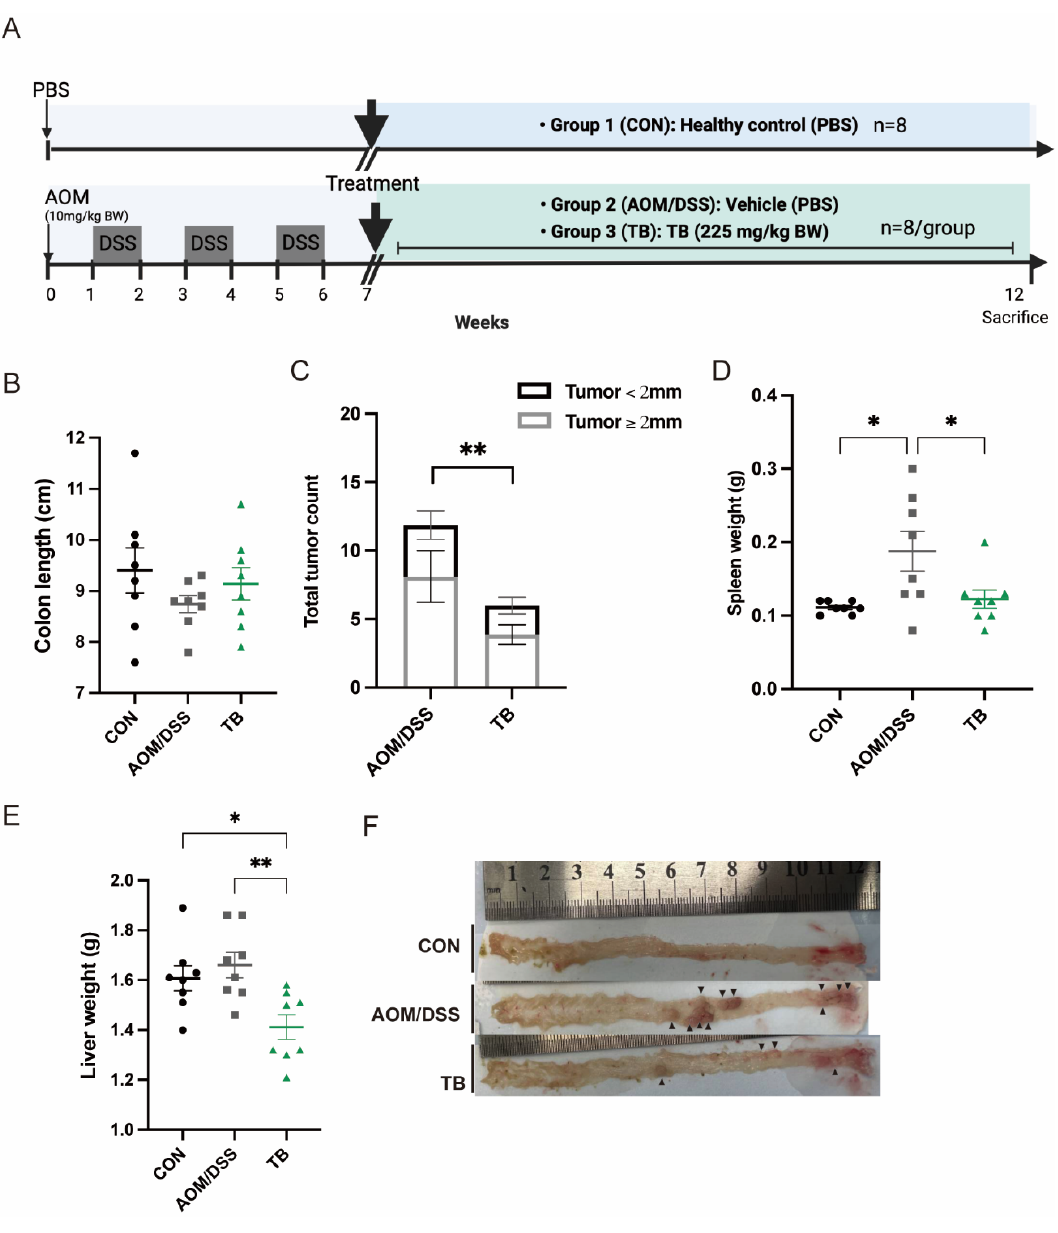
Figure 1. TB suppresses the development of colon tumors in AOM/DSS model. ( A ) Diagram illustrating the AOM/DSS model employed in this study. ( B ). Length of colon in cm. ( C ) Tumor count from colon and its size distribution. ( D ). Spleen weight. ( E ). Liver weight. ( F ). Representative pictures of colon illustrating the presence and location of colorectal tumors, black arrows indicate polyps. n = 7–8 per group. * p < 0.05, ** p < 0.01.